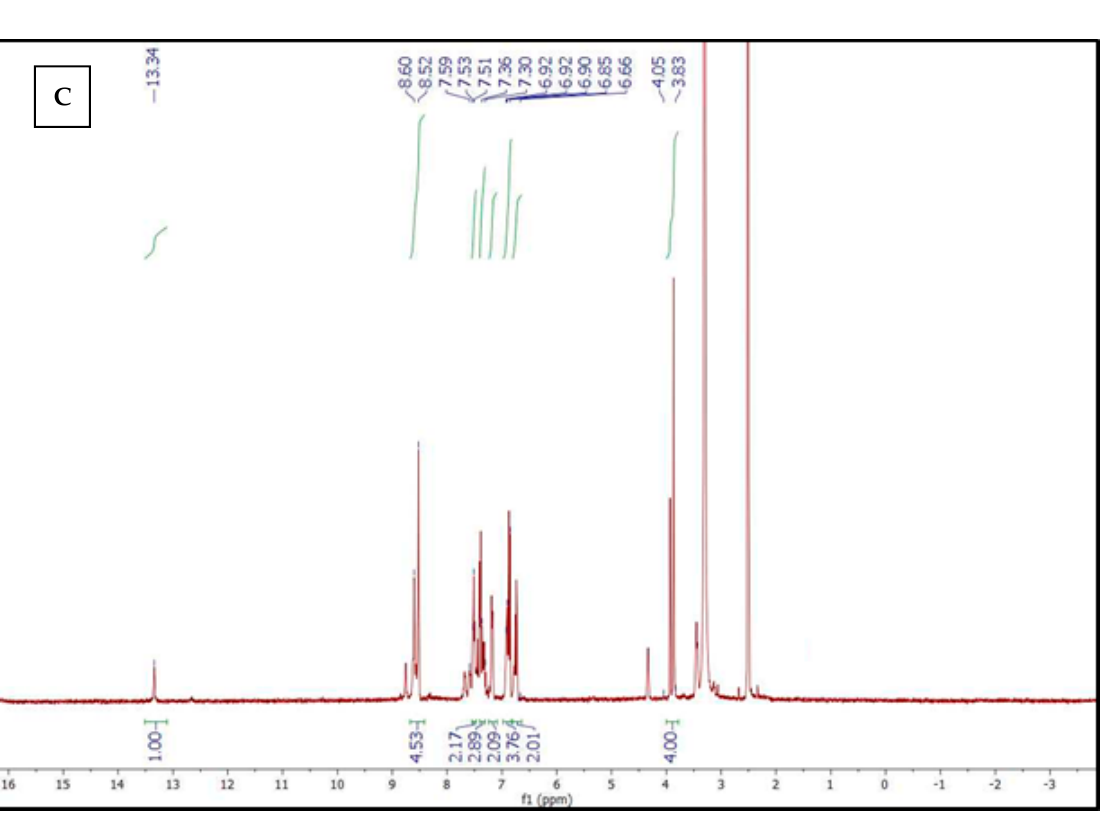
Figure 1. 1 H NMR spectrum of salen ( A ), CdSQ ( B ), and AlSQ ( C ) complex in DMSO- d 6 . Table 2. 1 H and 13 C NMR data in ppm for mixed-ligand Cd(II) and Al(III) metal complexes.